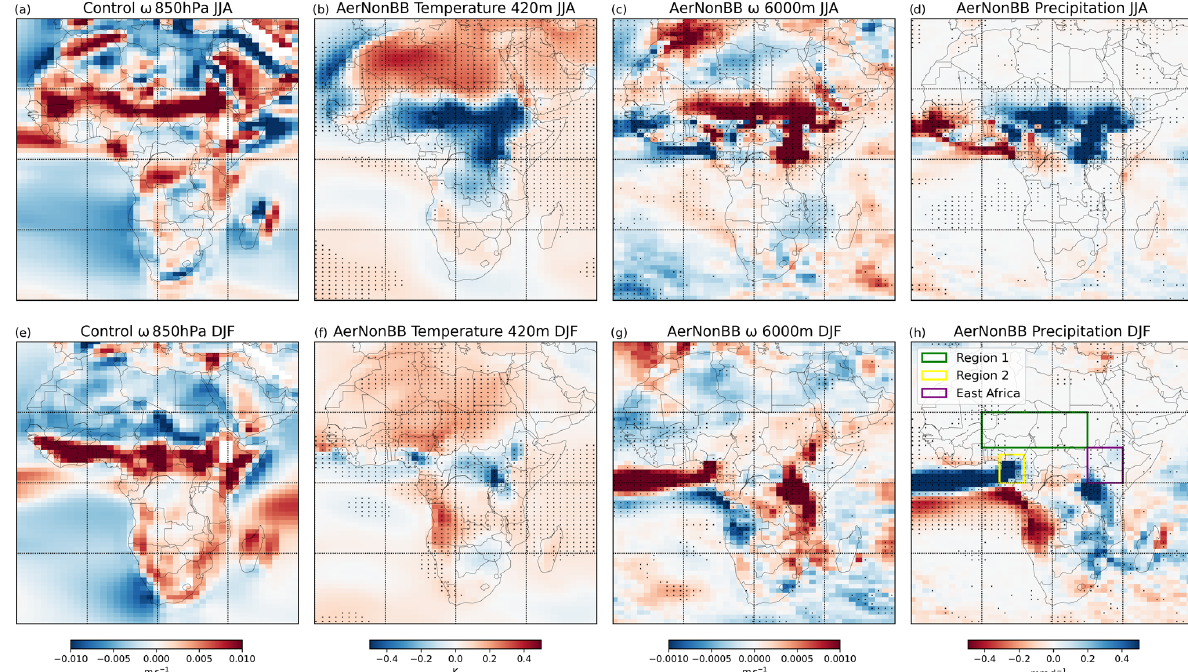
Figure 9. Background 850hPa vertical velocity in the control (a, e) and the AerNonBB-induced 2070–2100 changes in temperature at 420m (b, f) , vertical velocity at 6000m (c, g) , and surface precipitation (d, h) over Africa for JJA (a–d) and DJF (e–h) . Stippling indicates significant changes when compared to the inter-member